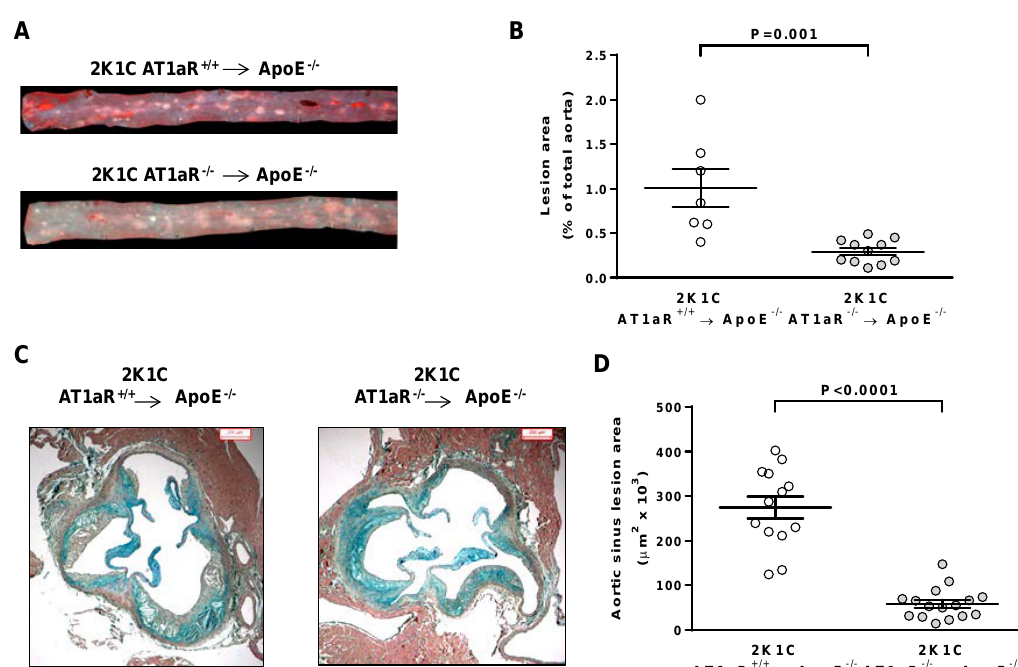
Figure 2. Effect of AT1aR deficiency in BM-derived cells on Ang II-mediated atherosclerosis. ( A ) Representative photographs of pinned-out aortas en face stained with Oil red O (lipid staining) from 2K1C ApoE − / − mice transplanted with either AT1aR +/+ or AT1aR − / − BM; ( B ) quantitative morphometric analysis of aortic plaque surface expressed as % of lipid deposition of the total aortic area analyzed ( n = 7 to 11 animals per group); ( C ) representative photographs of aortic sinus cross-sections stained with Movats pentachrome (scale bar = 200 µ m); ( D ) quantitative morphometric analysis of aortic sinus plaque area expressed in µ m 2 ( n = 13 to 16 animals per group). Circles represent individual mice, horizontal lines indicate the mean, and error bars represent SEM.